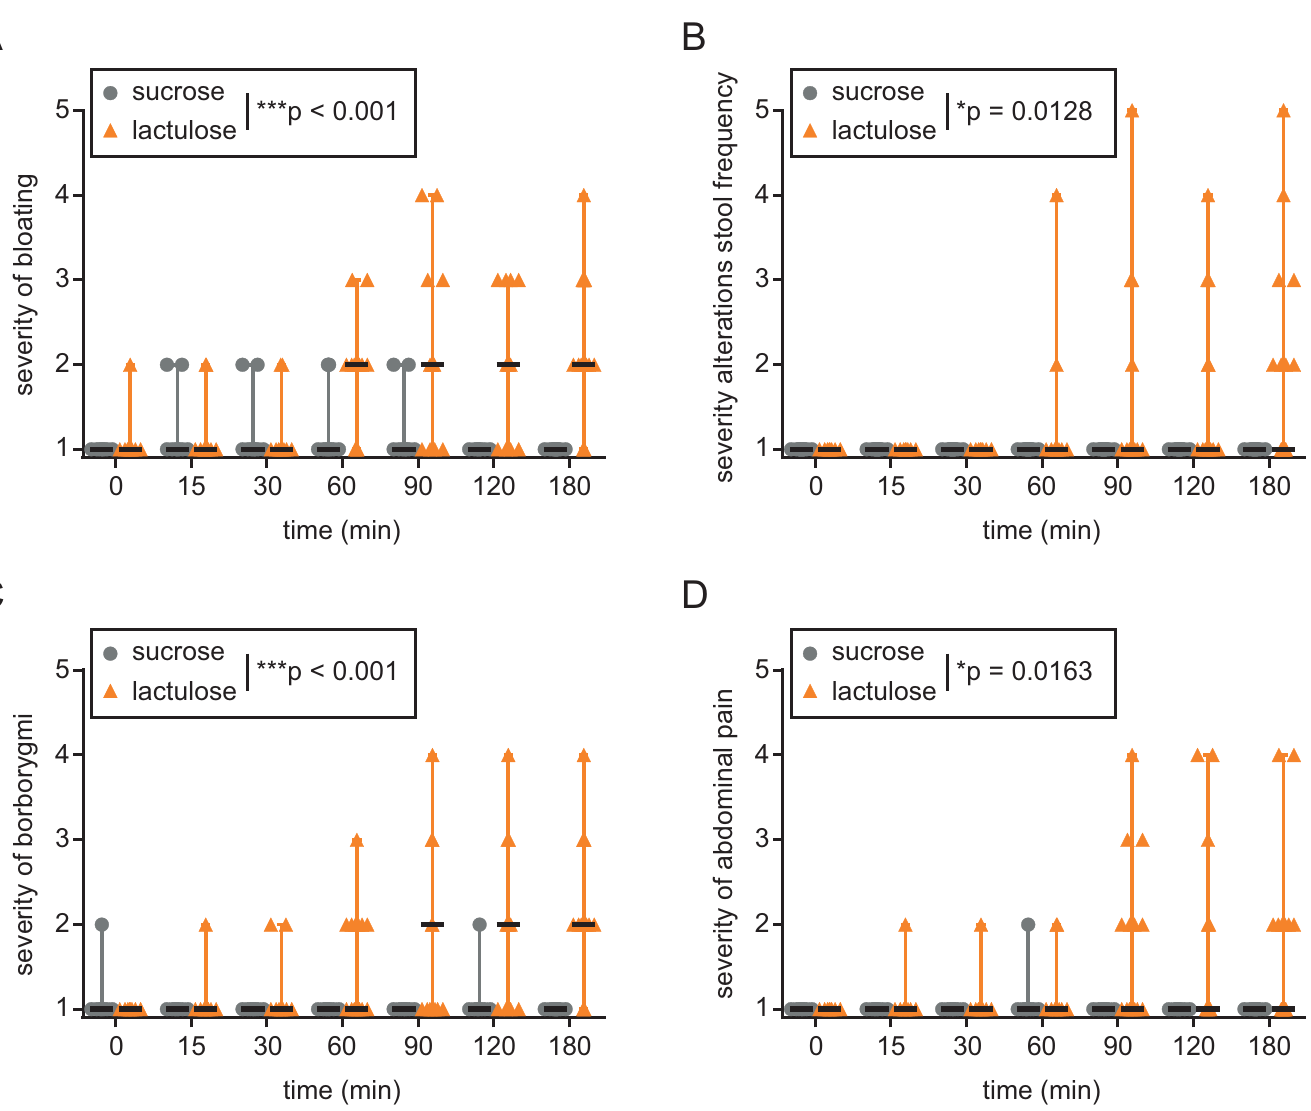
Fig 3. Symptoms upon lactulose or sucrose ingestion. Severity of (A) bloating, (B) stool alterations, (C) borborygmi and (D) abdominal pain was rated by individual participants according to the following scale: 1—no symptoms, 2 –symptoms which can be ignored), 3 –symptoms which cannot be ignored, but don’t affect daily activities, 4 –symptoms affecting daily activities, 5 –symptoms dominating and severely inhibiting daily activities. � p < 0.05, ��� p < 0.001; Two-way repeated measures ANOVA.